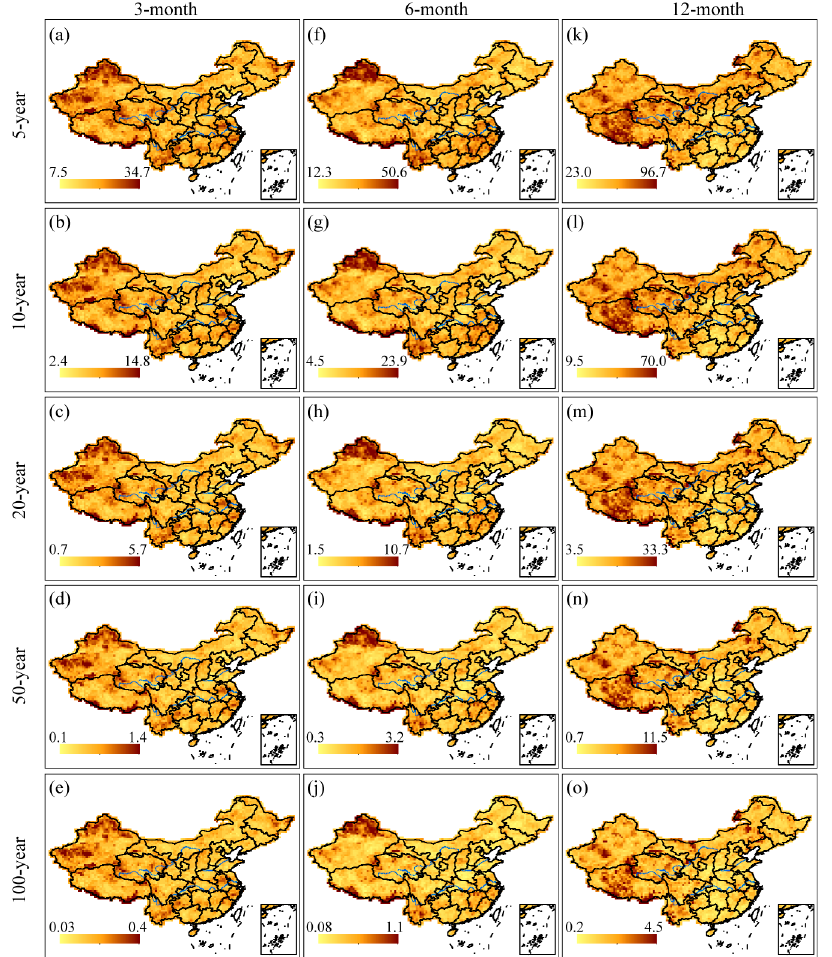
Figure 7. Joint probability (%) of drought duration and severity. The thresholds s and d are derived from drought severity and duration for 5-, 10-, 20-, 50-, and 100-year return periods, respectively. Specifically, ( a – e ) in each panel show the spatial patterns of joint probability with return periods of 5-, 10-, 20-, 50-, and 100-year at the 3-month time scale; ( f – j ) in each panel depict the corresponding patterns at the 6-month time scale; and ( k – o ) in each panel illustrate the patterns at the 12-month time scale.